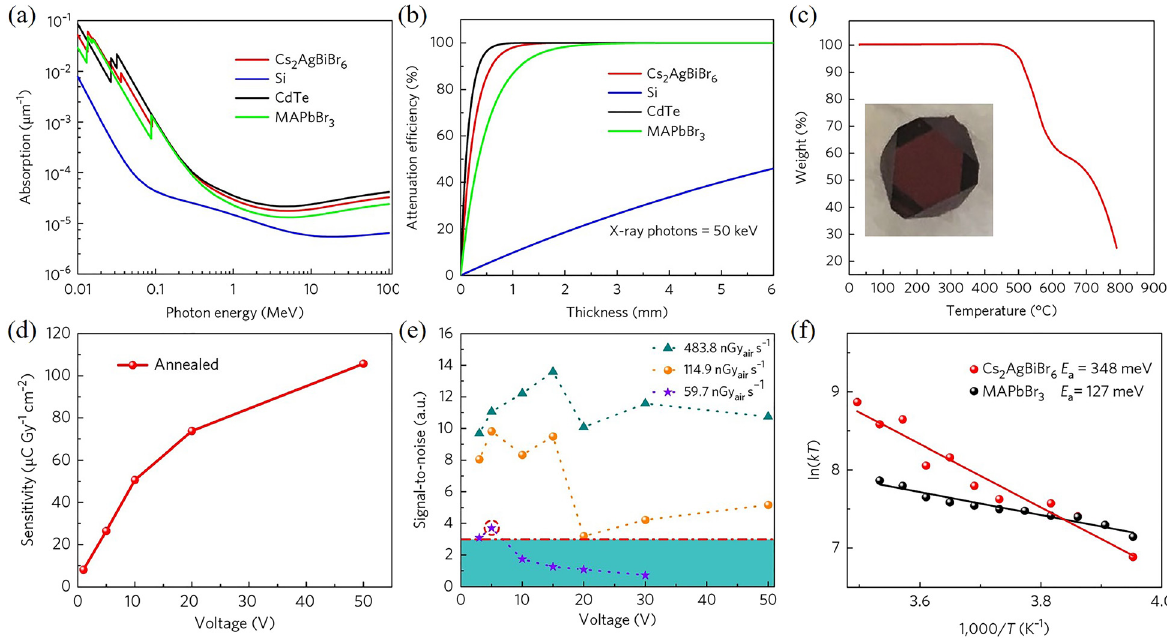
Figure 9: Characterizations of Cs 2 AgBiBr 6 SC for X-ray detection. (a) Simulated dependence of the absorption coefficients of Cs 2 AgBiBr 6 , MAPbBr 3 , CdTe, and Si on photon energy in a wide range spanning from X-rays to gamma radiation. (b) Thickness-dependent X-ray attenuation ef fi ciency in several representative semiconductors, the selected X-ray photon energy is 50 keV. (c) Thermogravimetric analysis curve of Cs 2 AgBiBr 6 . Inset: photograph of the Cs 2 AgBiBr 6 SC. (d) Sensitivity of the Cs 2 AgBiBr 6 single crystal-based X-ray detector versus bias. (e) Signal-to-noise ratio of the device versus bias, the ratio is derived by calculatingthe standarddeviation of thephotocurrentuponX-rayirradiation.(f) Arrheniusplotsof thekT-1000/T relationship to calculate the activation energy of ion migration. Reproduced with permission. Copyright 2017, Springer Nature